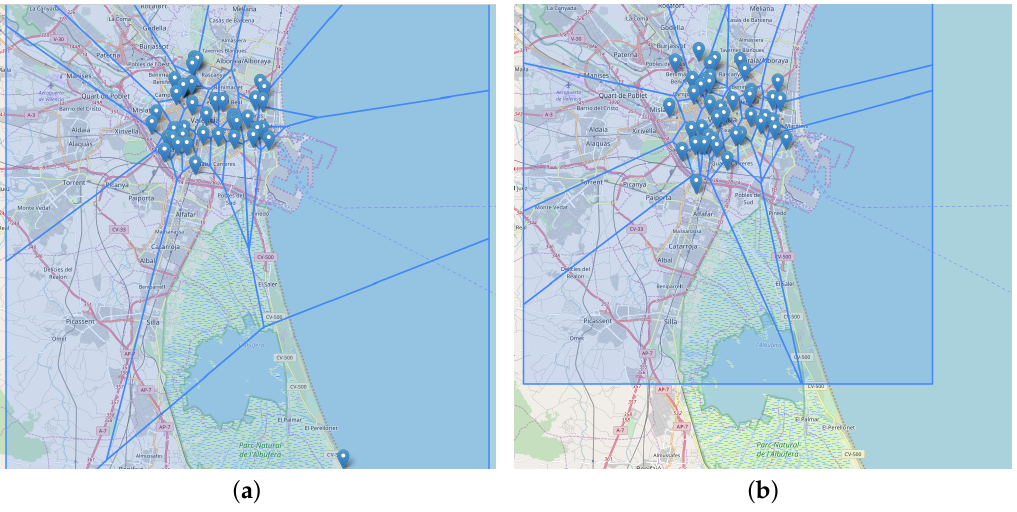
Figure 9. Computed solutions by the genetic algorithm for the city of Valencia. ( a ) Solution with a fitness value of 0.563; ( b ) Solution with a fitness value of